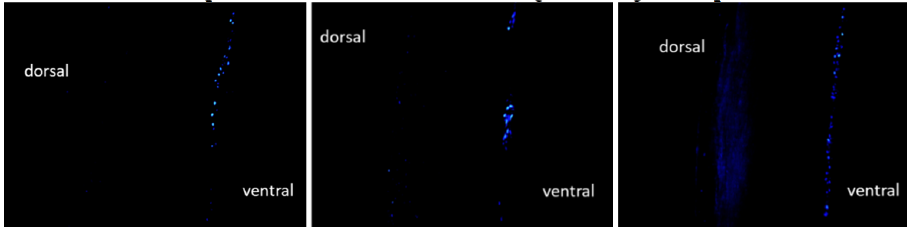
polish remover soaked free edges of fingernail plates. ( a ): Cross-sectional anti-ceramide antibody staining of normal free edges of fingernail plates and nail polish remover soaked free edges of fingernail plates ( left : No. 1, middle : No. 2, right : No. 3). ( b ): Cross-sectional anti-glucosylceramide antibody staining of the normal free edges of fingernail plates and nail polish remover soaked free edges of fingernail plates ( left : No. 1, middle : No. 2, right : No. 3). ( c ): Nuclear staining of normal